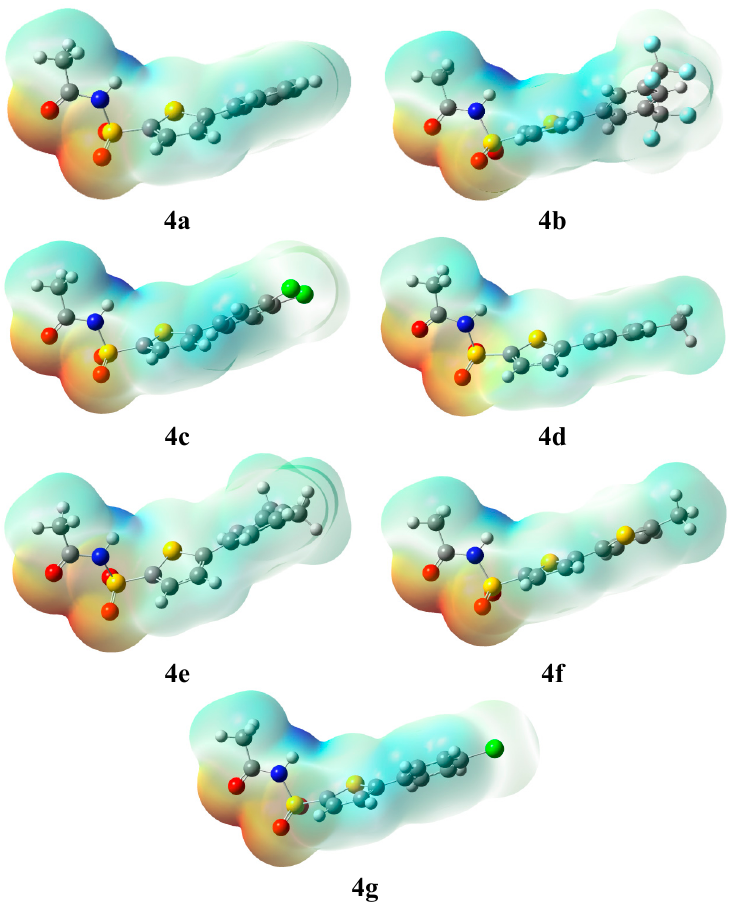
Figure 2. MEP Surfaces of all products 4a – g .